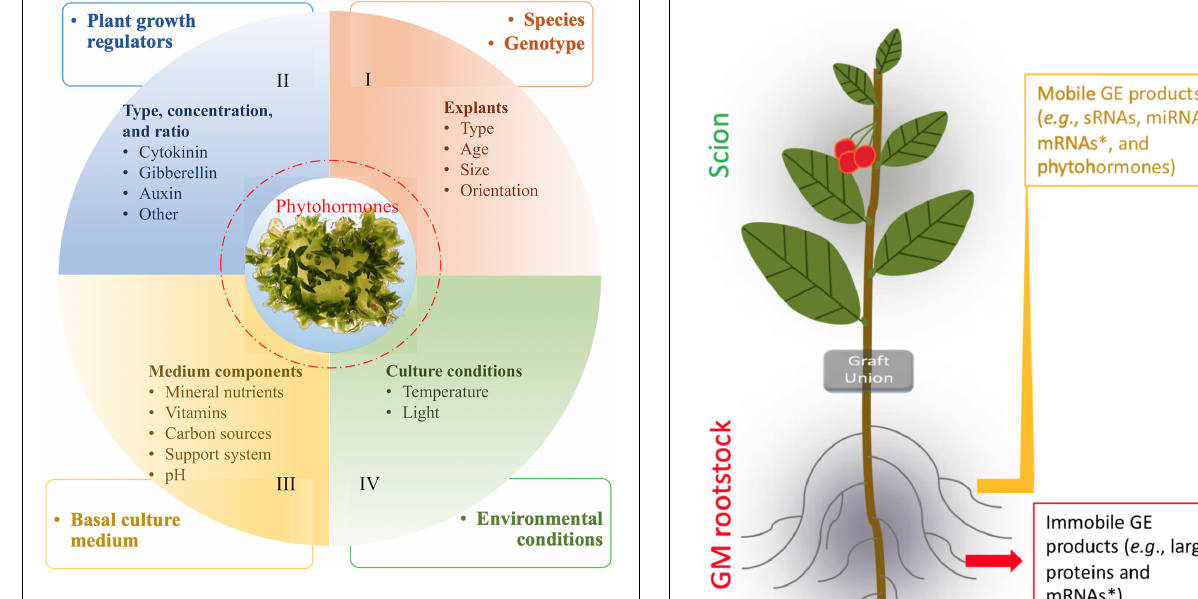
FIGURE 3 | Factors affecting regeneration of plant cells [An example of shoot organogenesis from leaf explants of blueberries (Song and Sink, 2004; Liu et al., 2010)]. We hypothesize that regeneration capability is determined by endogenous phytohormone levels, which are genetically controlled (I) and can be affected by II–IV.